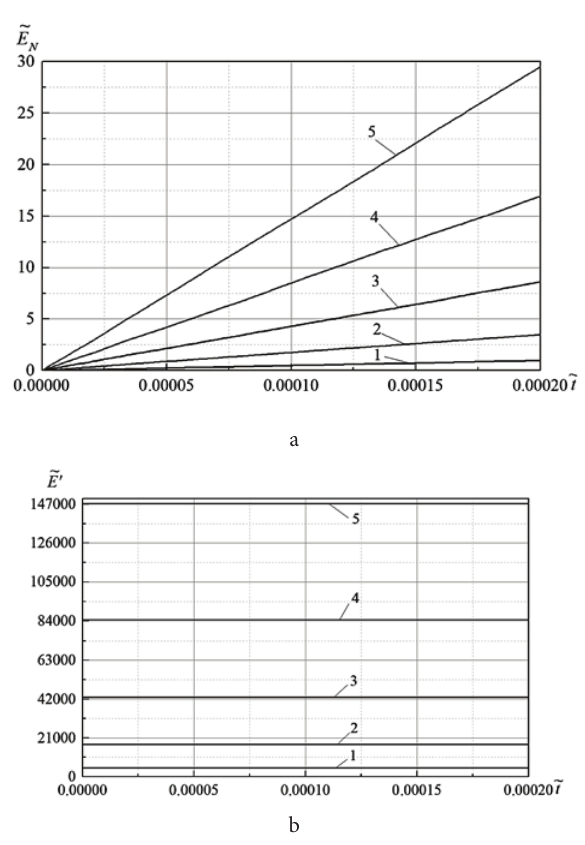
Fig. 3. Diagrams of variable accumulated energy C n ( a ) and rate of accumulated energy E'  ( b ) of a resulting acoustic emission signal and their time characteristics according to expression (2) and pertaining to the accepted values of α  , which are the following: 1 – α  = 200, 2 – α  = 300, 3 – α  = 400, 4 – α  = 500, 5 – α  = 600. Modelling parameters according to expression (1) are as